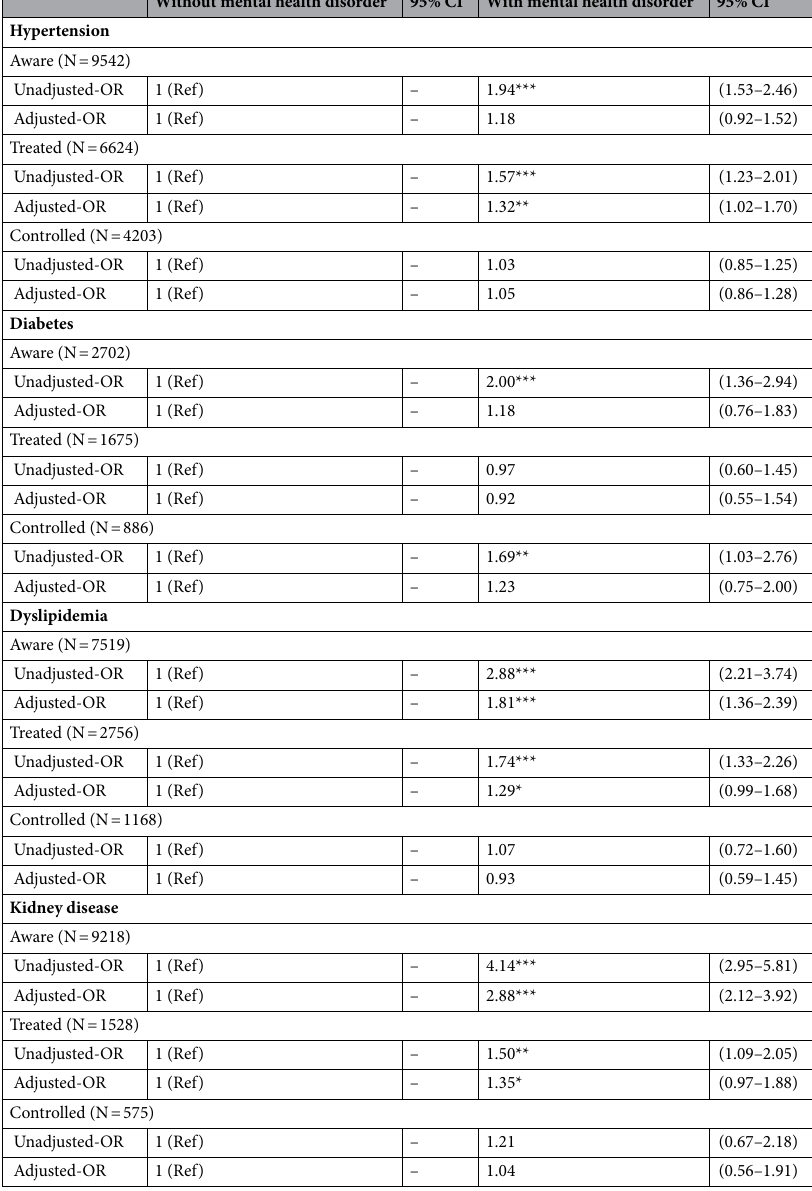
Table 3. Effect of mental health disorder on NCD awareness, treatment, and control. OR odds ratio CI confidence interval. *** P < 0.01, ** P < 0.05, * P < 0.1. This table provides the results from the unadjusted and adjusted mixed-effect logistics regression. For awareness, people with chronic physical condition and without mental health disorder was the reference group. For treated, people with self-report physical chronic condition and without mental health disorder was the reference group. For controlled, people with self-report physical condition, and with self-report treatment for this chronic condition, but without mental health disorder was the reference group. Adjusted mixed-effect logistic regressions adjusted variables, such as age, gender, education, marital status, consumption level, insurance, residency, region, and number of outpatient visits in the last